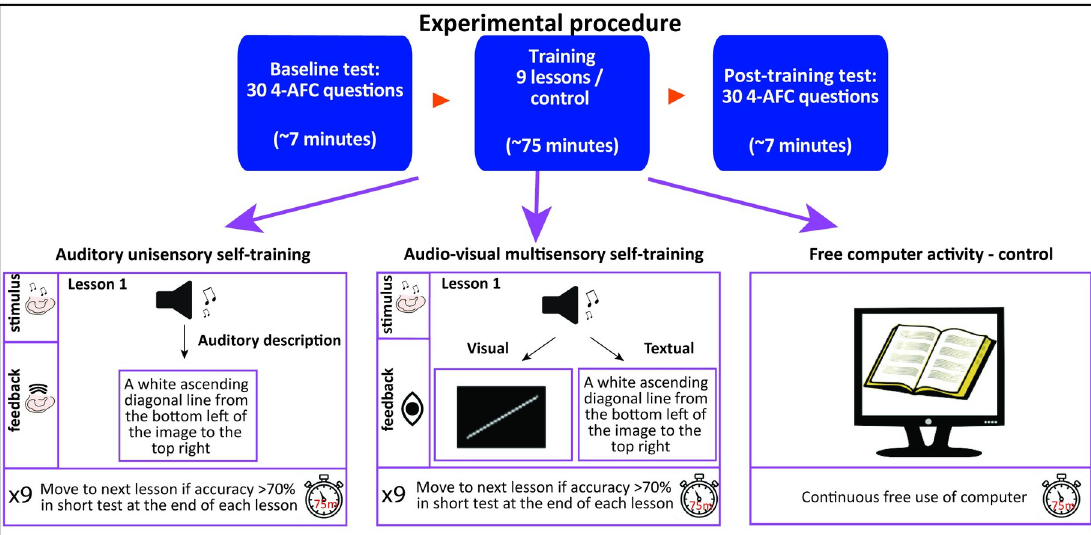
Fig 2. Experimental flow. The experiment included 5 groups of sighted participants, 4 experimental groups, and 1 control group. All participants performed a baseline SSD identification test, and repeated the same test after ~75 minutes. Between tests, the 4 experimental groups participated in a self-learning online training program consisting of 9 step-by-step lessons of increasing difficulty guiding them through the basic principles of the EyeMusic. The feedback method deployed during training to teach the participants to interpret the auditory stimuli of the EyeMusic, varied among groups: 1 Auditory only unisensory group receiving an auditory description of the stimuli after each EyeMusic stimulus; and 3 Audio-visual multi-sensory groups—2 groups perceiving visual images appearing either simultaneously or following the EyeMusic stimuli; 1 group receiving textual descriptions of the stimuli alongside hearing the auditory stimulus; In the control group participants were instructed to free reading from the computer during the ~75 minutes between the two SSD identification